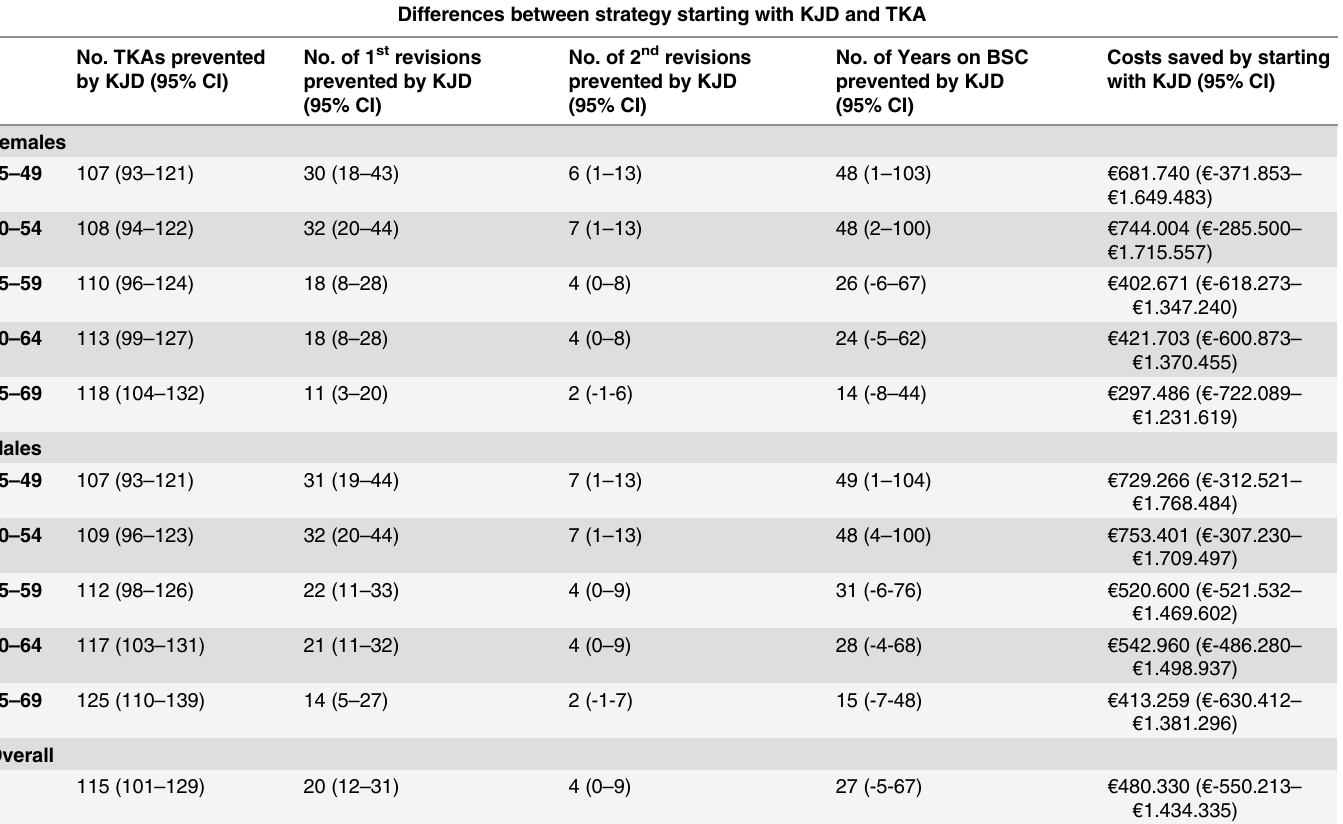
Table 3. Differences between strategy starting with KJD and TKA after 20-years. Overall result: weighted average with weights according to the pro- portion of patients in the different gender and age categories undergoing TKA in the Netherlands